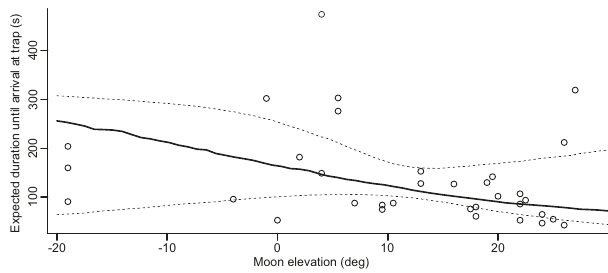
Fig. 1 Expected fl ight duration of a moth. Flight duration (black line) was calculated as the median fl ight duration predicted by the Cox PH model ( p = 0.014, n = 34) for arrivals within 8 minutes after release and averaged over all individuals. Circles represent the actual measured values. Dashed lines indicate the con fi dence interval of the predicted duration at α = 5% level estimated by bootstrapping (5000